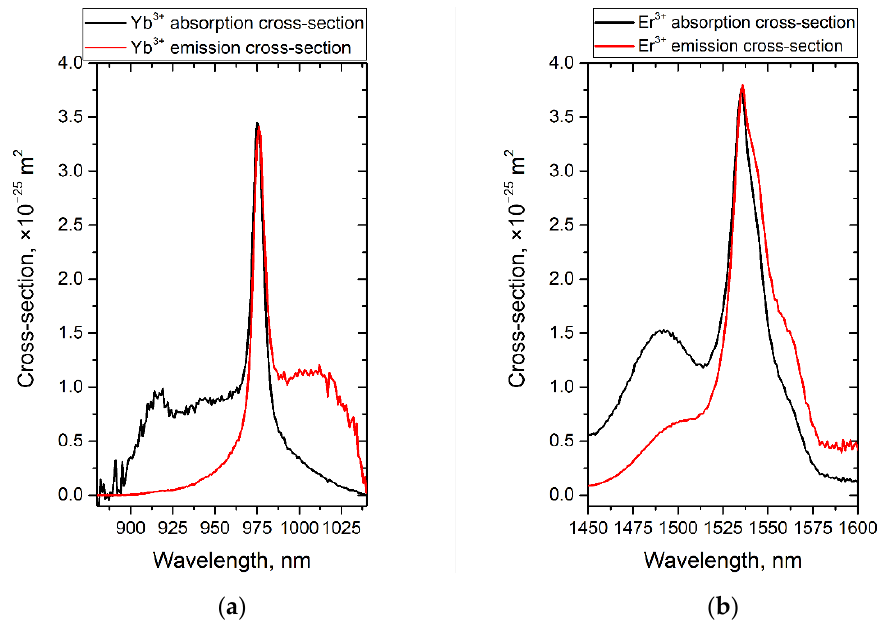
Figure 4. Absorption and emission cross-section spectra calculated from absorption measurements and other parameters for ( a ) Yb 3+ and ( b ) Er 3+ .